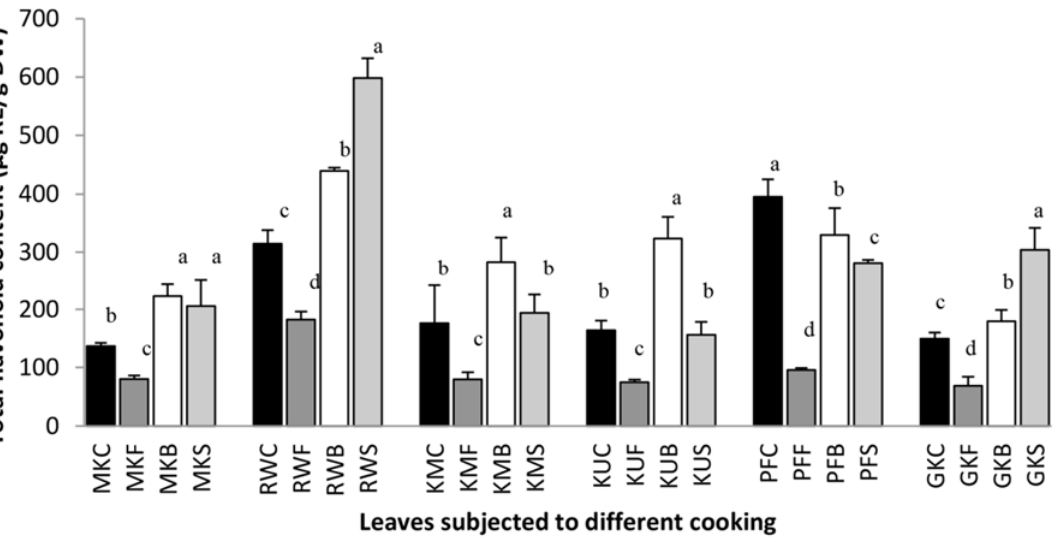
Figure 2. Total flavonoid content of raw and cooked extracts of some green leafy vegetables. Values represent the means of triplicate readings. MK, O. zeylanica ; RW, C. auriculata ; KM, S. grandiflora ; KU, G. lactiferum ; PF, P. edulis ; GK, C. asiatica . C—fresh leaves; F—fried; B—boiled; S—steamed. Data are means ± standard deviations of three replicate determinations. Columns with different letters for each vegetable are significantly different ( p < 0.05). RE: rutin equivalance.